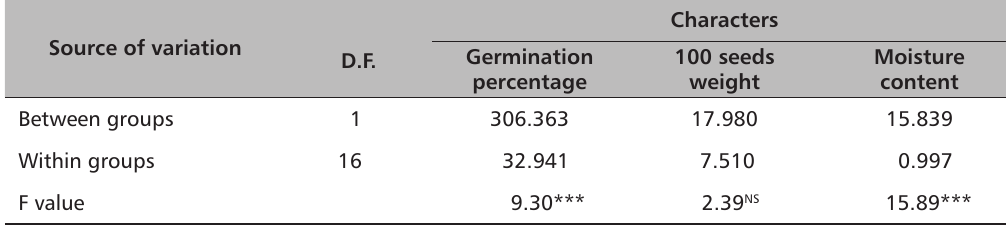
TABLE 1. Analyses of variance for elevation